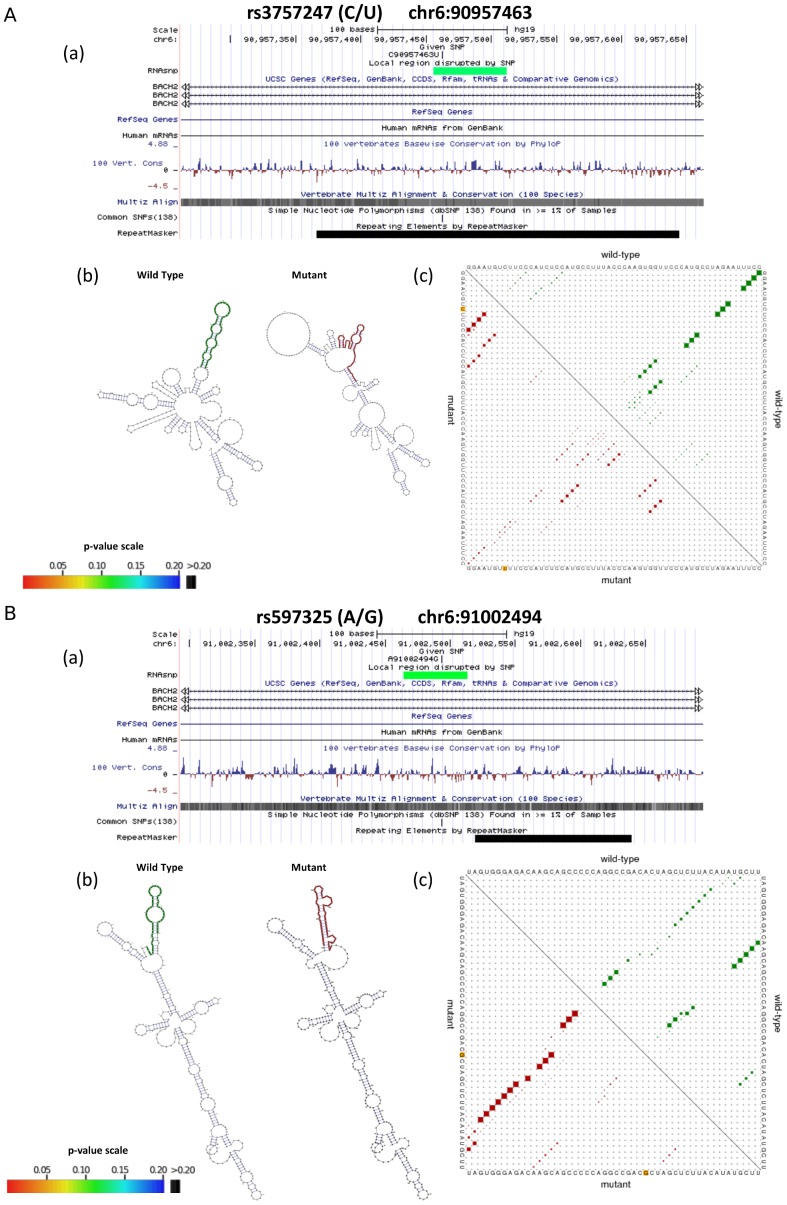
Structure disruption of lncRNA NONHSAG044354-associated with BACH2 (implicated in both IBD and T1D) by GWAS SNPs rs3757247 and rs597325.The structure-disruptive effects of SNPs rs3757247 (A) and rs597325 (B) located in lncRNA NONHSAG044354 associated with candidate gene BACH2. (a) UCSC genome browser view showing the location of the predicted local region disrupted by the SNP. The color of predicted local region (green in this case) is based on the RNAsnp p-value (0.129 and 0.120 for rs3757247 and rs597325 respectively). (b) Minimum free energy structures (MFE) of the global wild-type and mutant sequences displaying the secondary structure and the local region affected by the SNP position, colored green (wild-type) and red (mutant) (c) Dot plot representing the base pair probabilities of wild type and mutant RNA sequences corresponding to the predicted local region by RNAsnp. The upper and lower triangle of the matrix represents the base pair probabilities of wild-type (green) and mutant (red), respectively.